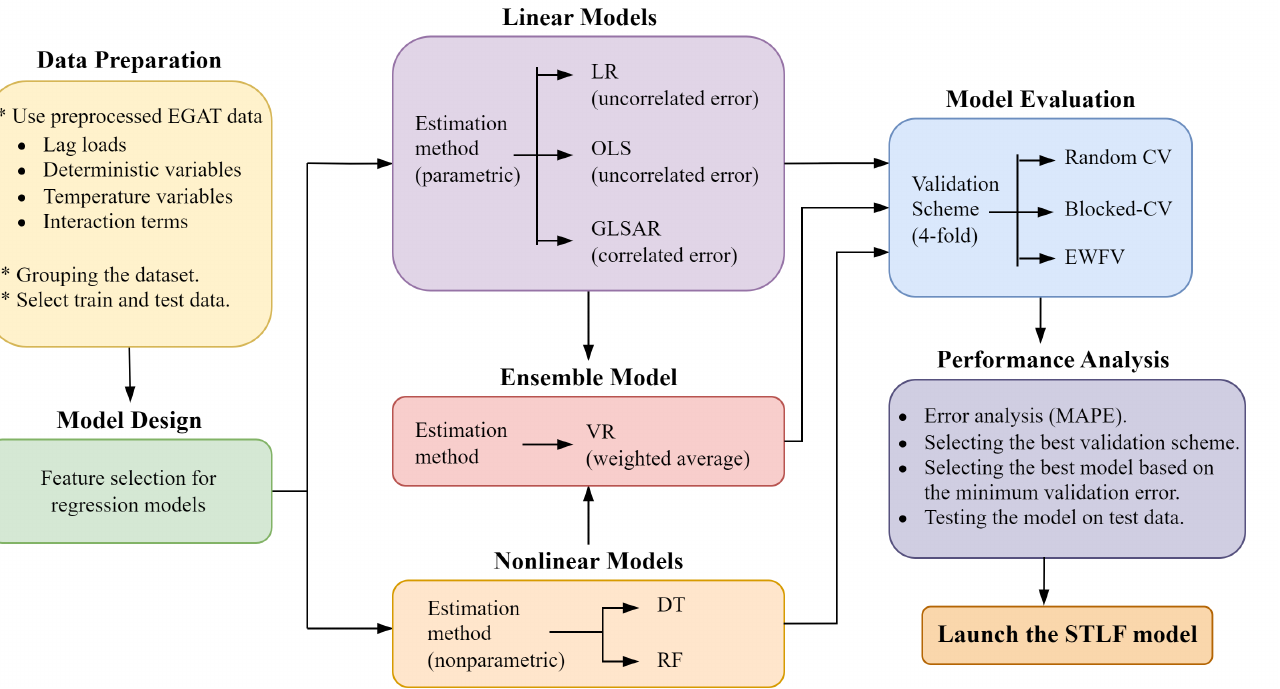
Figure 2. Proposed